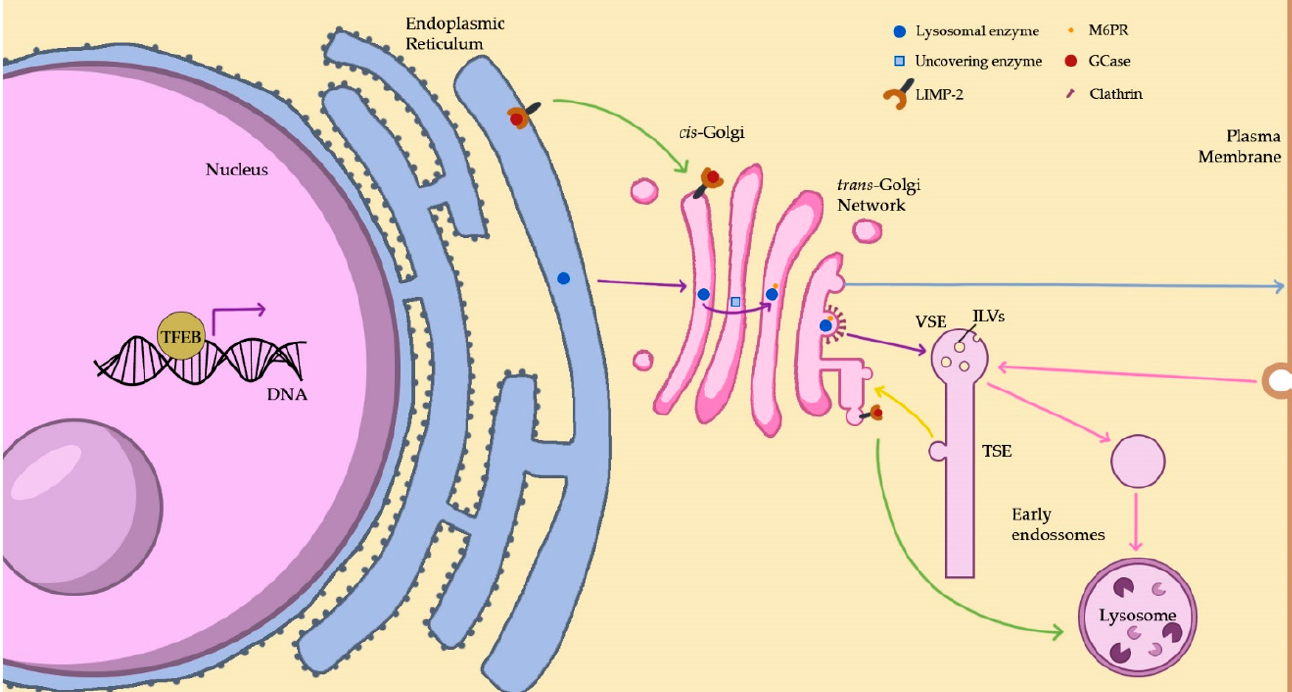
Figure 1. The lysosomal biosynthetic and endocytic pathways. Under starvation, TFEB is translocated to the nucleus and binds genes coding for lysosomal proteins, upregulating protein synthesis and initiating the biosynthetic pathway (purple arrows). Proteins are transported to the ER lumen. The proteins then travel to the cis -Golgi, some proteins require a membrane protein for this transport, like the β -Glucocerebrosidase (GCase) LIMP-2 mediated-transport (green arrows). In the cis -Golgi, the uncovering enzyme uncovers the mannose 6-phosphate (M6P) sugar in lysosomal proteins. Lysosomal proteins then arrive to the TGN, where Mannose 6-phosphate receptors (M6PR) recognize the M6P tag and are packed into clathrin-coated vesicles. Lysosomal proteins reach early endosomes (EE) and dissociate from M6PR and remain in the endosomal lumen. The M6PR can be recycled, returning to the TGN by the endosome to TGN carriers (yellow arrows). Endosomal intermediates transport the lysosomal proteins to the lysosomes through the endocytic pathway (pink arrows). Other proteins that don’t have specific target characteristics, may follow the constitutive secretory pathway to the plasma membrane (blue arrows) and reach lysosomes by endocytosis. VSE—vacuolar sorting endosome; ILVs—intraluminal vesicles; TSE—tubular sorting endosome.